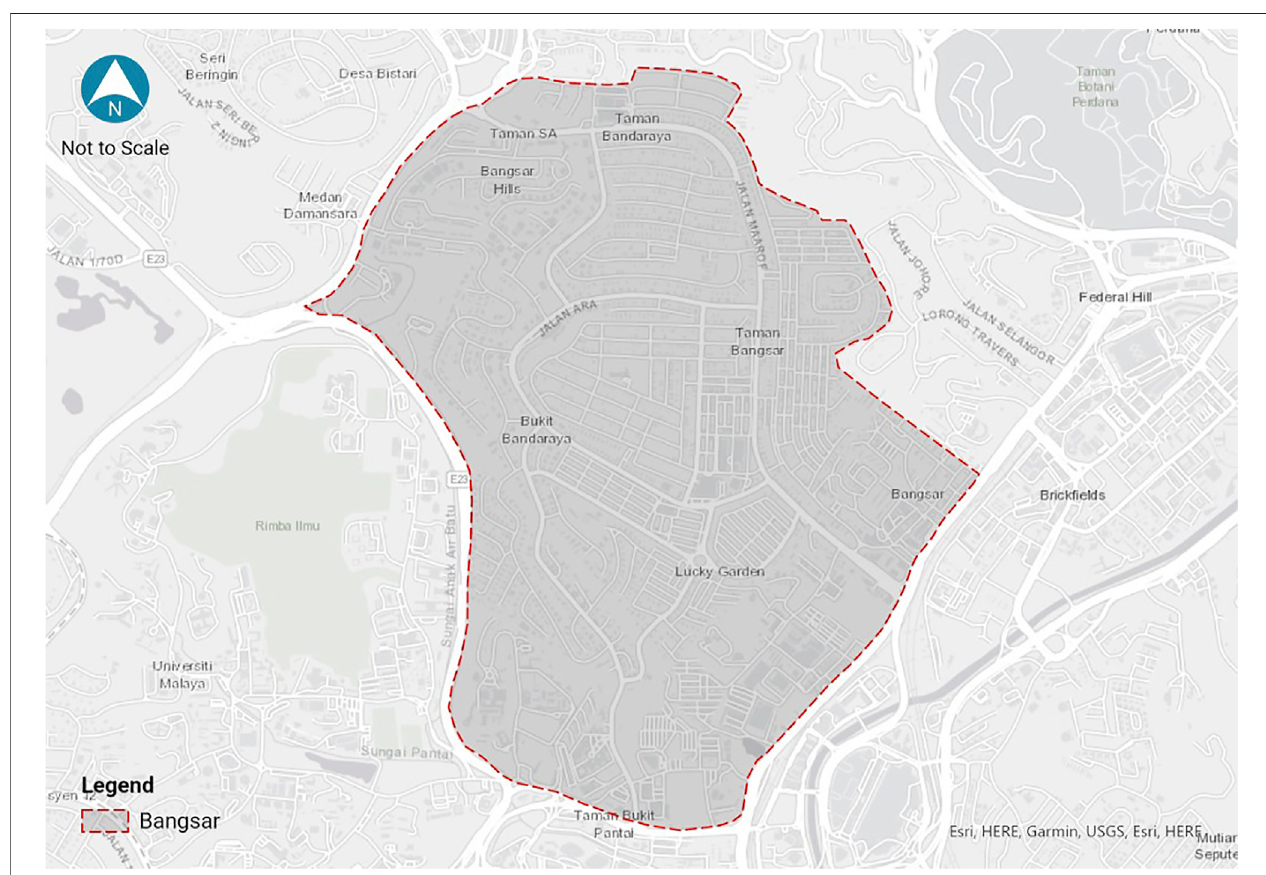
FIGURE1| MapofBangsar(Source:EnvironmentalSystemsResearchInstitute[ESRI],2021).MapFigureisfromArcGISOnlinemaphostedbyEsri.Wewouldlike to assure the images is retrieved from ESRI free platform and we have go through the disclaimer and noti fi cation details at https://doc.arcgis.com/en/arcgis-online/